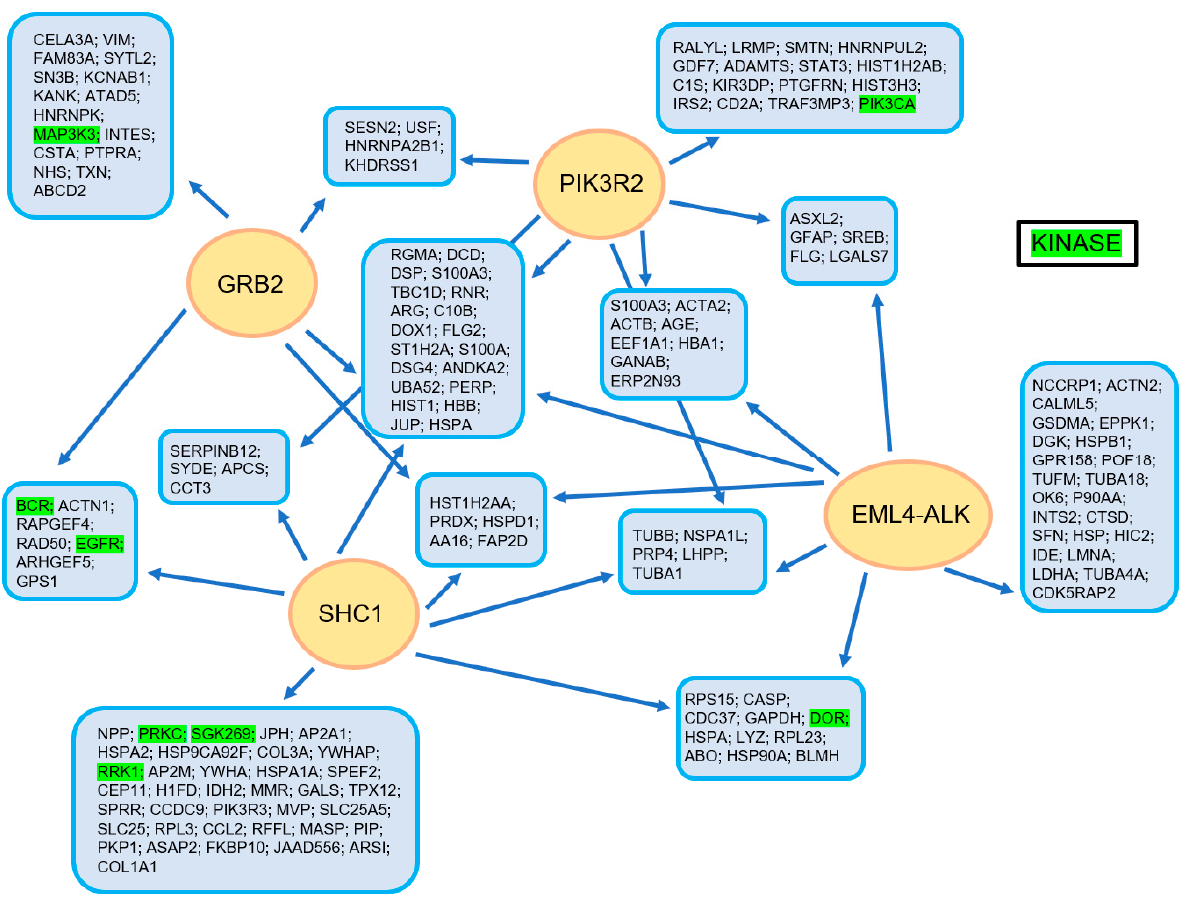
Figure 2. The EML4-ALK protein complex interaction model, as constructed using a tandem affinity purification approach with consecutive mass spectrometry. Reproduced from Golding et al. [11].